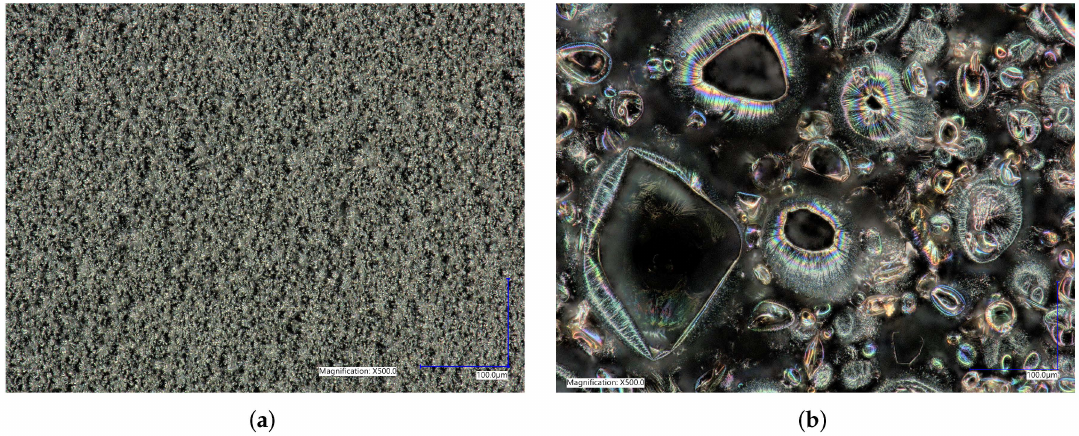
Figure 5. Surface morphology of ( a ) flat polypyrrole (PPy) films compared to ( b ) microstructured PPy films at 500X magnification showing the effectiveness of the horizontal plate method for the creation of round microstructures. Image ( b ) is an example of what was used for the feature size counting outlined in Figure